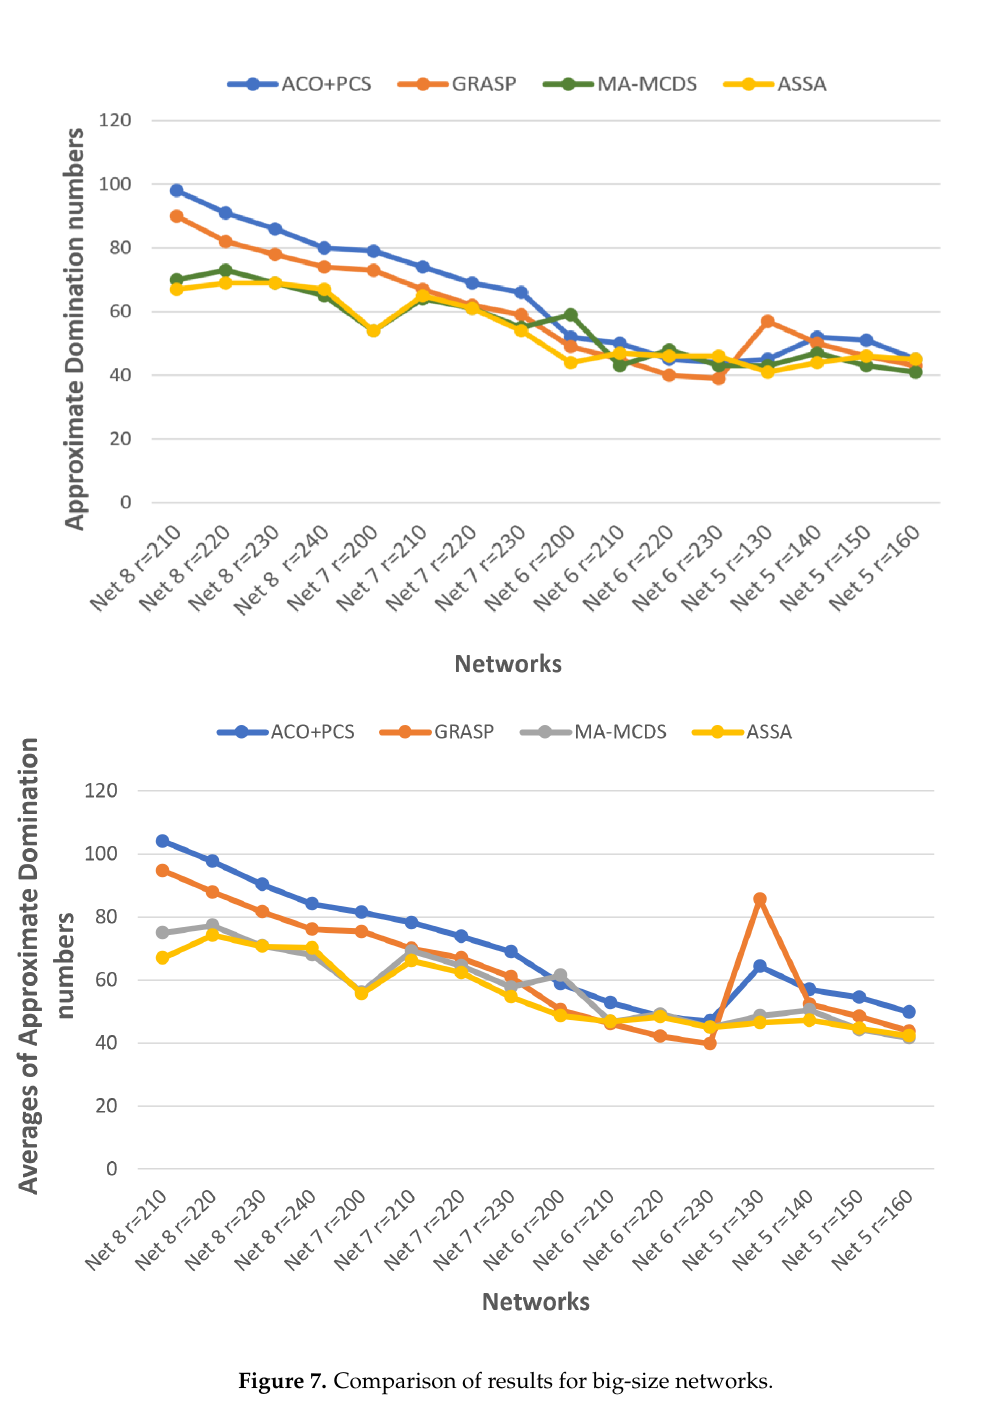
Figure 7. Comparison of results for big-size